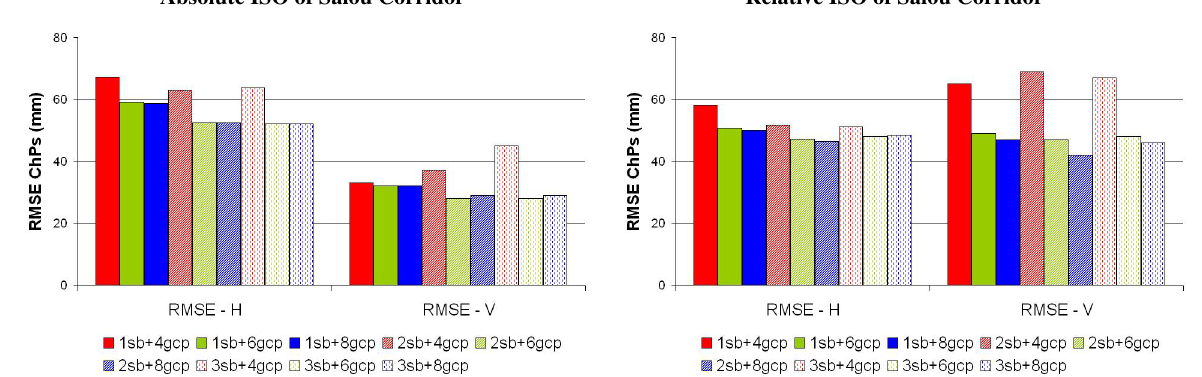
Figure 3: Accuracy of Pavia and Salou corridors for ISO with absolute and relative aerial